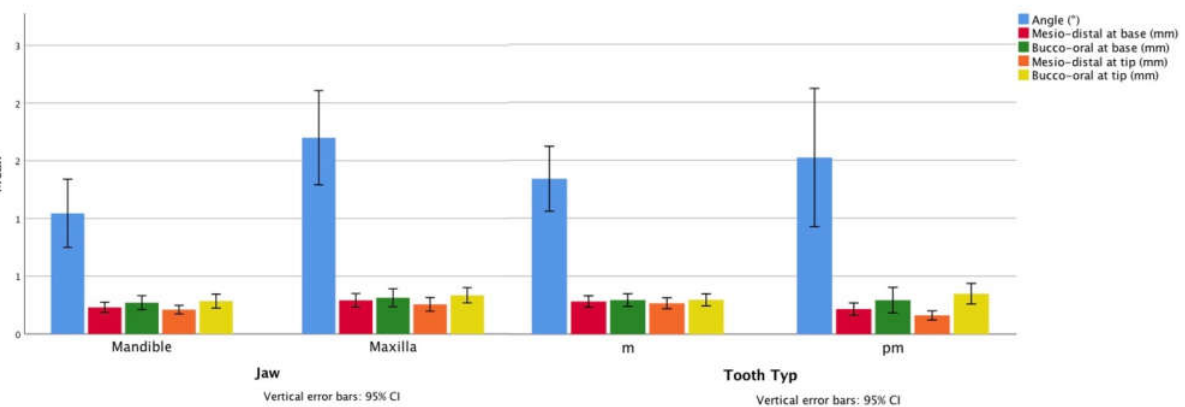
Figure 4. Mean angle deviation (°) and mean deviation at the base and the tip of the bur in the mesio-distal and bucco-oral dimensions (mm) by tooth location (maxilla vs. mandible) and type (premolar (pm) vs. molar (m)).